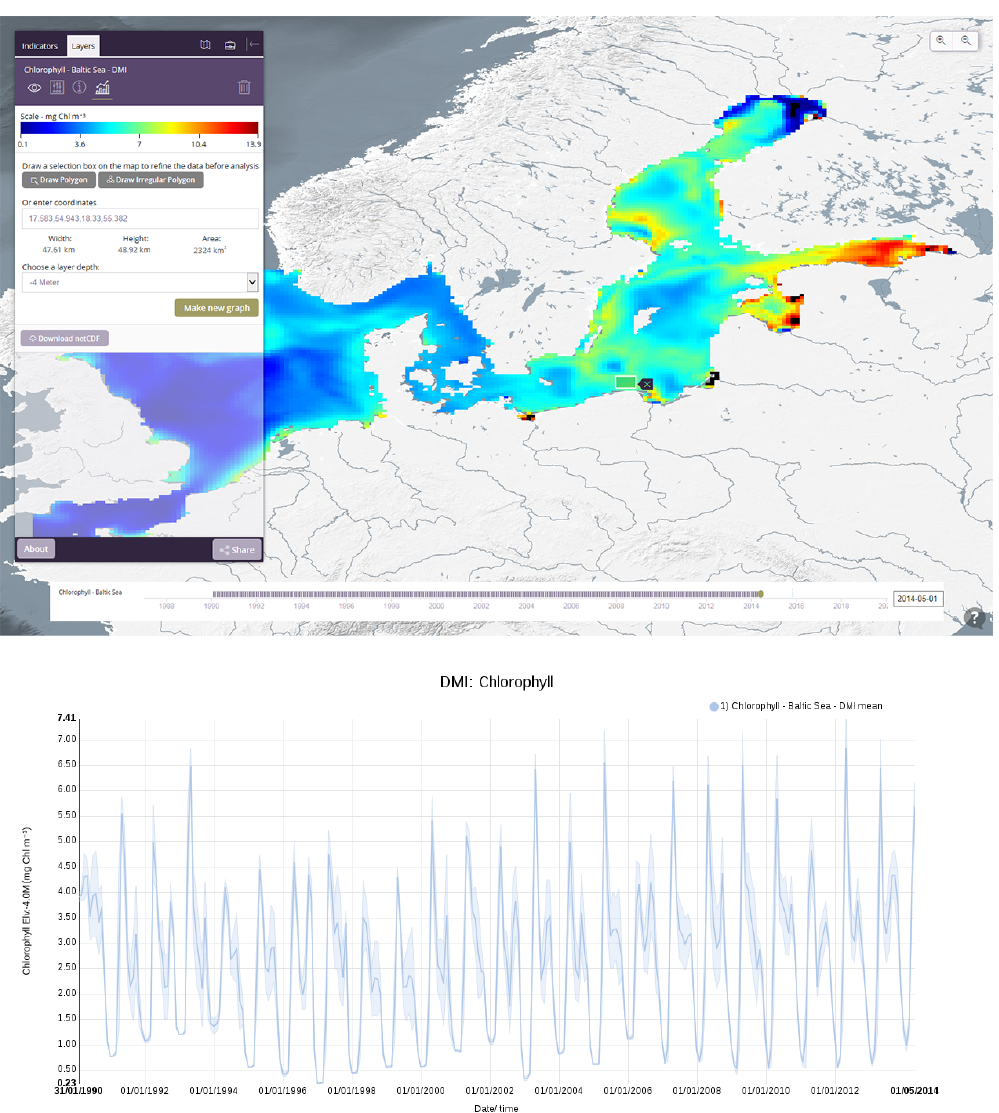
Figure 3. OPEC Rapid Environment Assessment and multi-decadal biogeochemical reanalysis: an example of Baltic Sea Chl a . Upper panel: OPEC data portal for extracting OE products; lower panel: monthly mean Chl a time series during January 1990–May 2014 at a selected rectangular polygon shown in the upper panel. The shadow area shows the monthly standard